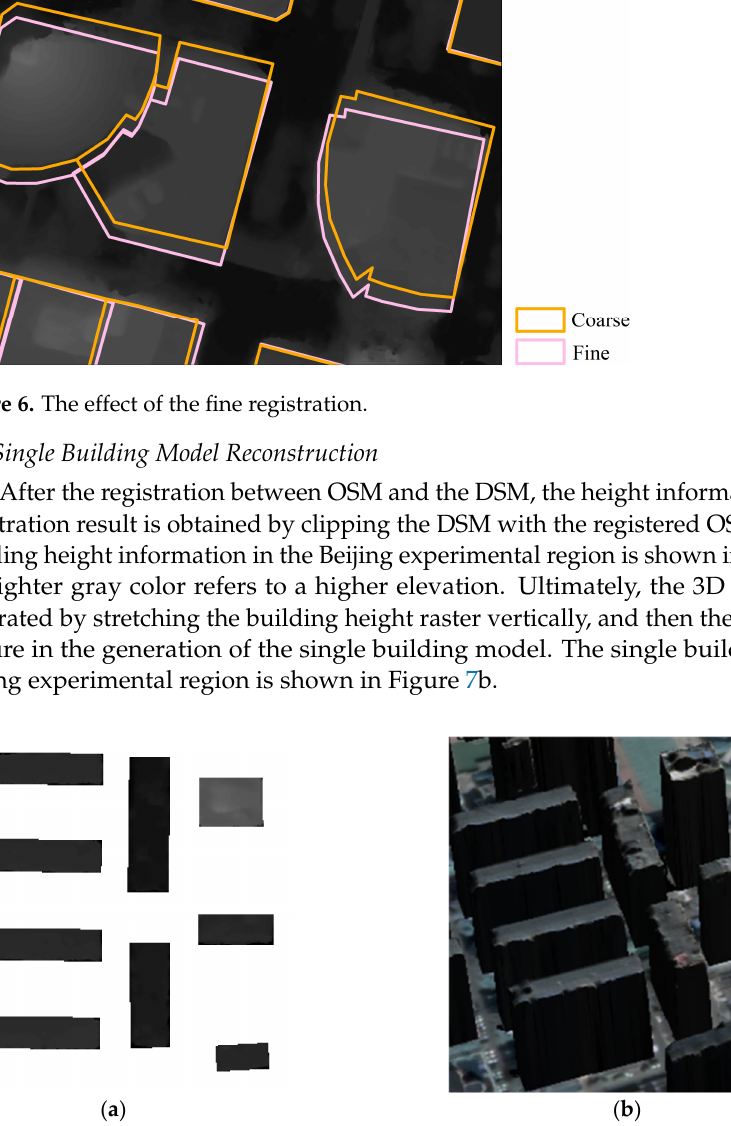
Figure 7. Single building model reconstruction process in Beijing experimental region, where ( a ) the building height raster is firstly generated and then ( b ) the single building model is